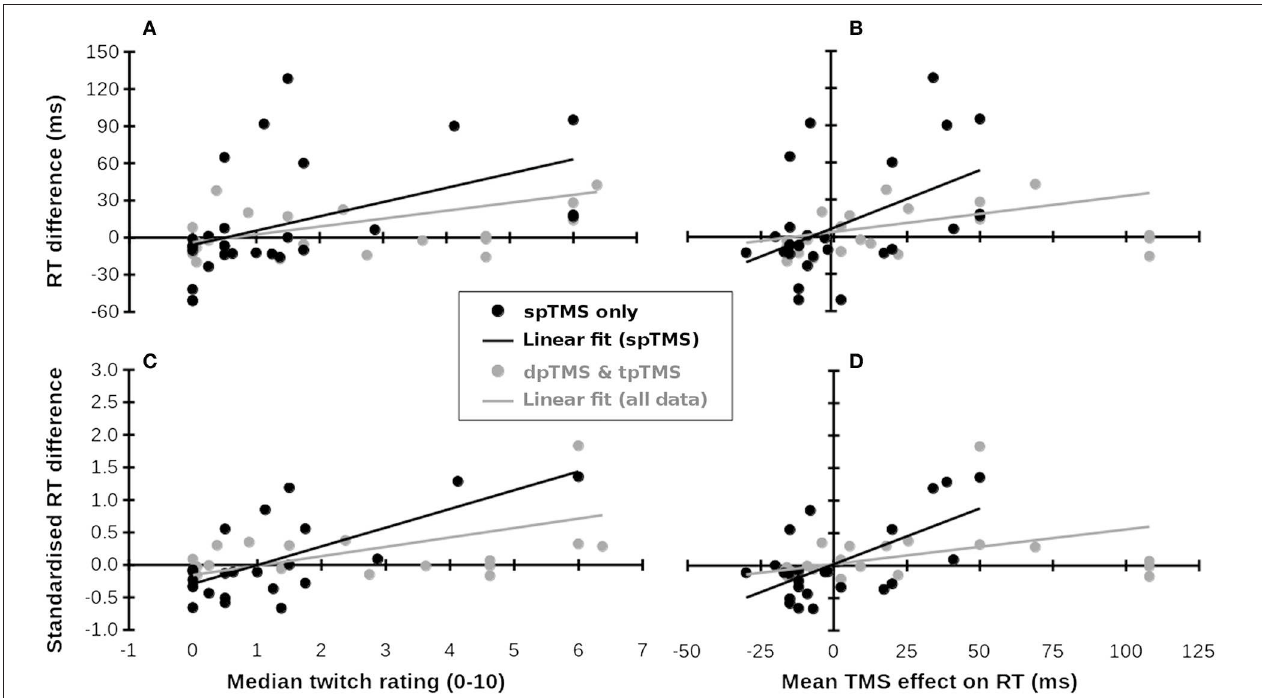
FIGURE 1 | Subjective ratings of muscle twitches and TMS-related RT increases (x-axes, from Meteyard and Holmes, 2018) predict RT differences in published studies (y-axes, multiple studies). (A–D) Show different measures. Black symbols and lines: single-pulse TMS data; Gray symbols: Double- (dp) and triple-pulse (tp) TMS data. Gray lines: Linear fit across all available data. Data for the x-coordinates were taken from Meteyard and Holmes (2018). Data for the y-coordinates were taken from Baldassarre et al. (2016), Busan et al. (2009a,b,c); Busan et al. (2012), Cattaneo et al. (2009, 2014), Chica et al. (2011), Fautrelle et al. (2013), Jackson et al. (2015), Johnson et al. (2012), Kehrer et al. (2015), Koch et al. (2008), Ku et al. (2015), Machizawa et al. (2010), Newman-Norlund et al. (2010), Oshio et al. (2010), Pasalar et al. (2010), Renzi et al. (2011), Ricci et al. (2012), Salillas et al. (2009, 2012), Schuhmann et al. (2009), Shinshi et al. (2015), Teige et al. (2018), Tunik et al. (2008), Vernet et al. (2008), Wheat et al. (2013), and Yan et al. (2016). (A) Median twitch ratings (x-axis) predict raw RT differences (y-axis). (B) Mean TMS effect on RT predicts raw RT differences. (C) Median twitch ratings (x-axis) predict standardized RT differences (y-axis). (D) Mean TMS effect on RT predicts standardized RT